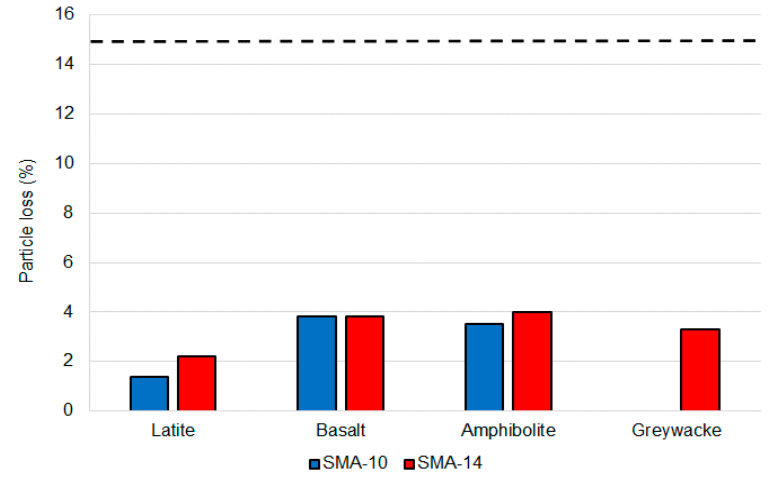
Figure 4. Particle loss rest results. Table 12. Binder drain down results.